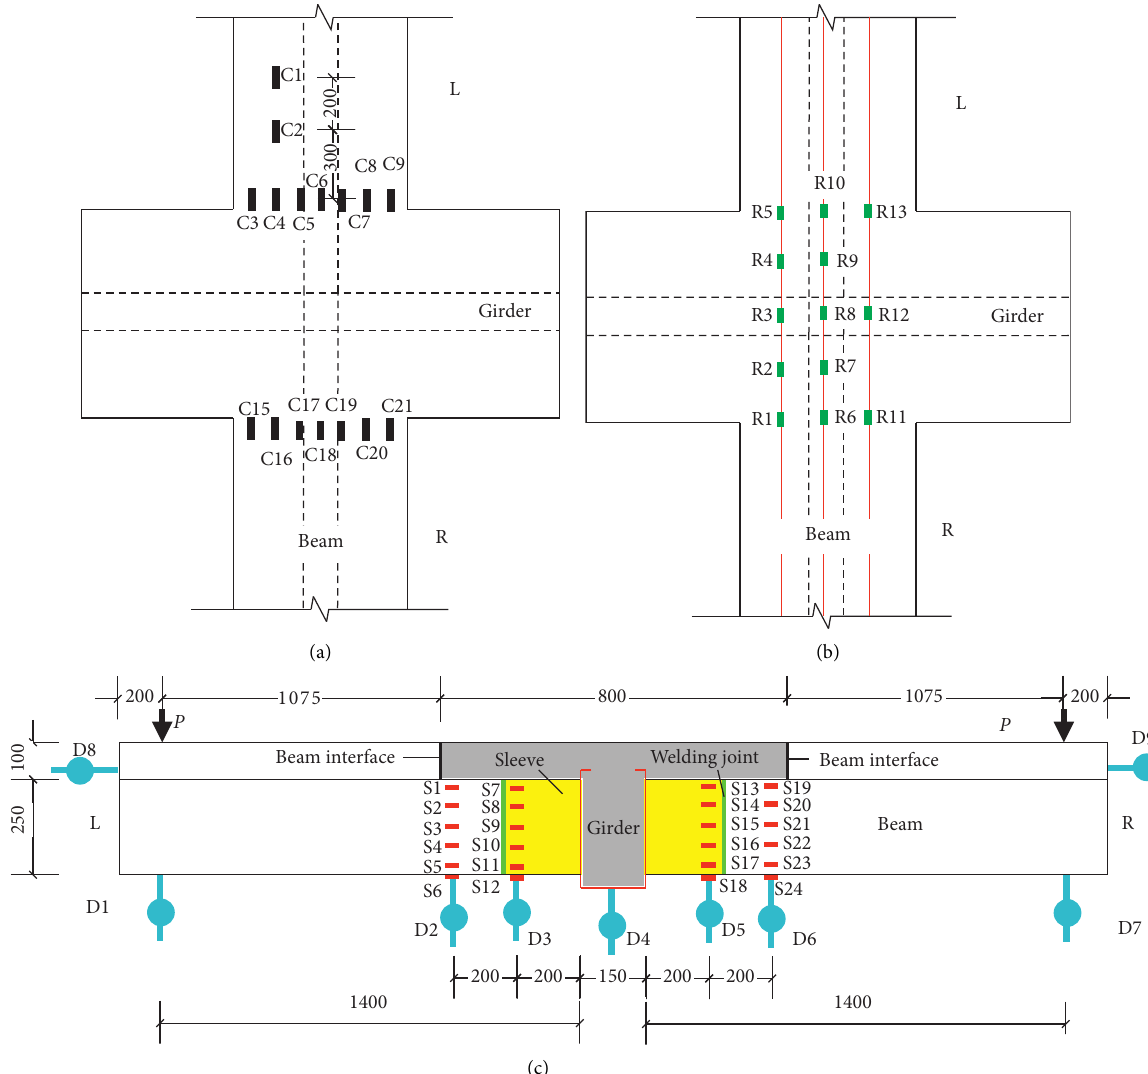
Figure 6: Measuring scheme. (a) Concrete strain gauges arrangement. (b) Reinforcement strain gauges arrangement. (c) Strain gauges arrangement of beam and shaped